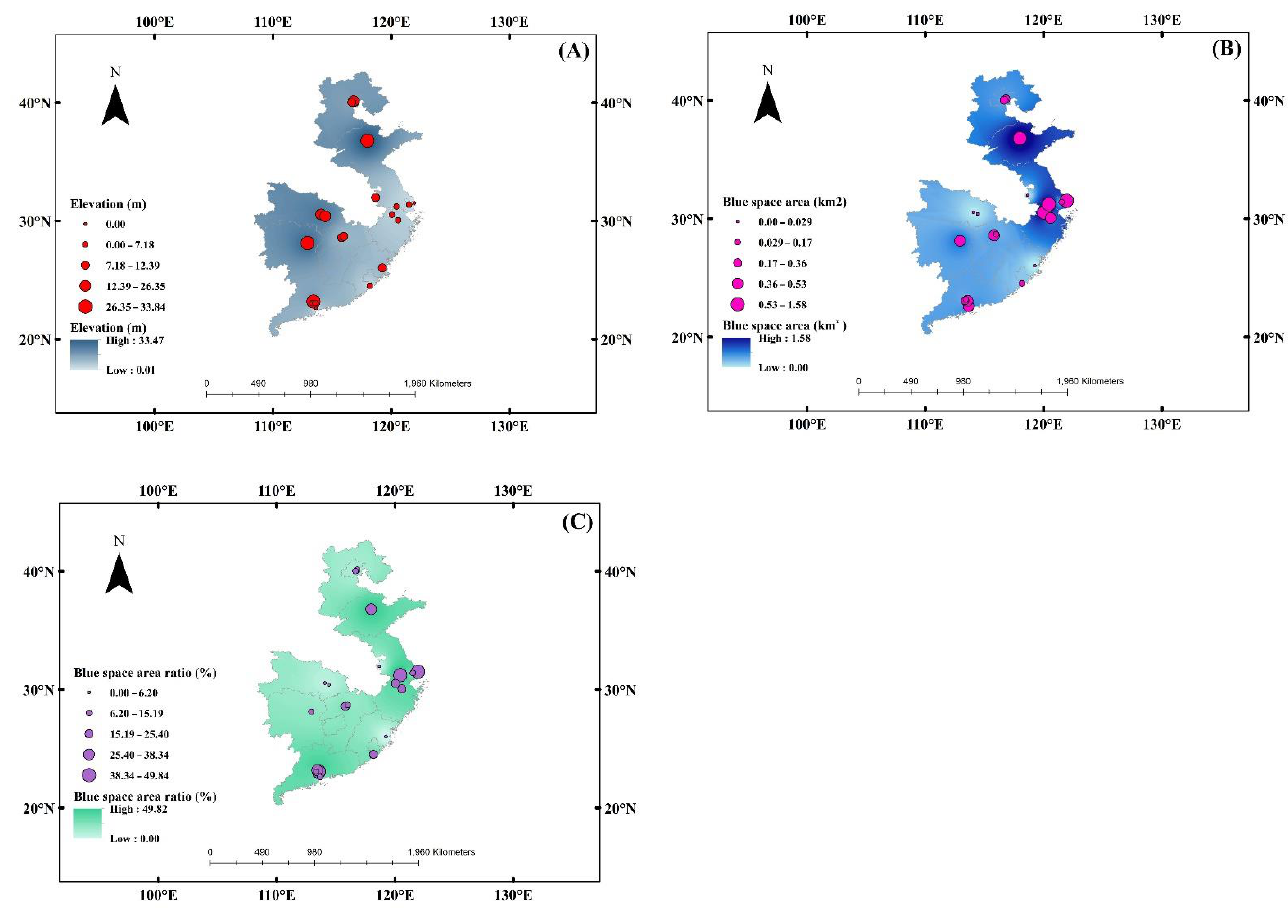
Figure 6. Spatial distributions of elevation ( A ), blue-space area ( B ), and blue-space area ratio to the whole park ( C ) of wetland forest parks in East China.